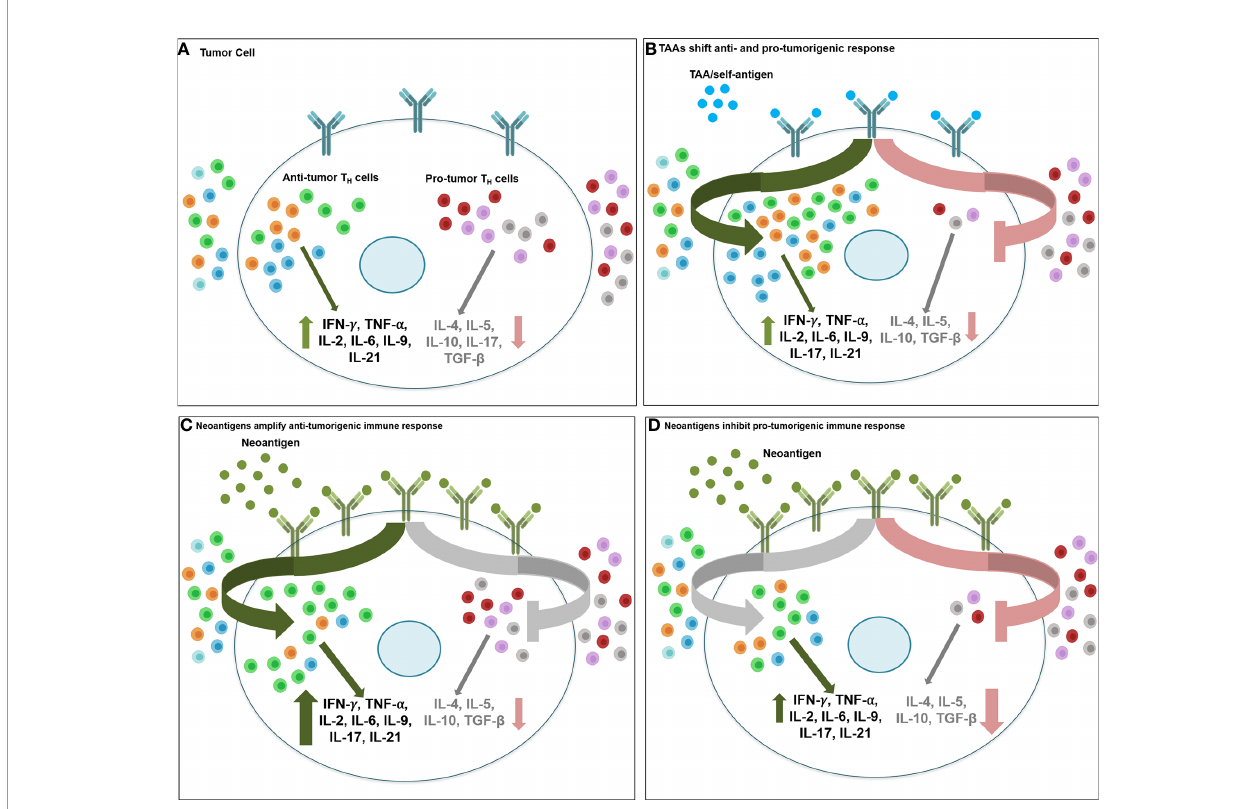
FIGURE 3 | Therapeutic targeting of tumor associated antigens and neoantigens activate anti- vs. protumorigenic CD4+ T H cell subtypes. Therapeutic targeting of oncodrivers/TAA/self-antigens may stimulate tumor immune response differently than strategies involving neoantigens. (A) Intratumoral balance of anti- and protumorigenic CD4 + T H immune cell population maintain the equilibrium of in fl ammatory (IFN- g , TNF- a , IL-2, IL-6, IL-9, IL-21) and inhibitory cytokines (IL-4, IL-5, IL- 10, TGF- b ) in cancer cell and determine overall immune response to therapy. (B) When tumor cells express self-antigens/TAA/oncodrivers ( blue spheres) , due to low abundance and weak immunogenicity of these antigens, effective immunotherapy targeting these proteins may require a more extensive shift in the balance of anti- vs pro-tumor immune effector populations, including recruitment and activation of all anti-tumorigenic T H 1/T H 9/T fh populations ( green arrow ) and suppression of all pro-tumorigenic T H 2/T H 17/T reg /MDSC function ( red arrow) . Conversely, highly antigenic and abundant neoantigens ( green spheres) may be suf fi cient to stimulate anti-tumor immune response either by (C) driving up in fi ltration and hyperactivation of primarilyT H 1, along with T H 9 and T fh immunostimulatory response ( green arrow ) with minimal changes in the inhibitory immune cell function ( grey arrow) or by (D) drastic downregulation of immunosuppressive response by T H 2/T H 17/T reg/ MDSC cells ( red arrow) without a signi fi cant change in the immunostimulatory population of T H 1/T H 9/T fh cells ( grey arrow) (light green, T H 1; red, T H 2; orange, T H 9; blue, T fh ; dark green, T H 17; grey, T reg ; purple,